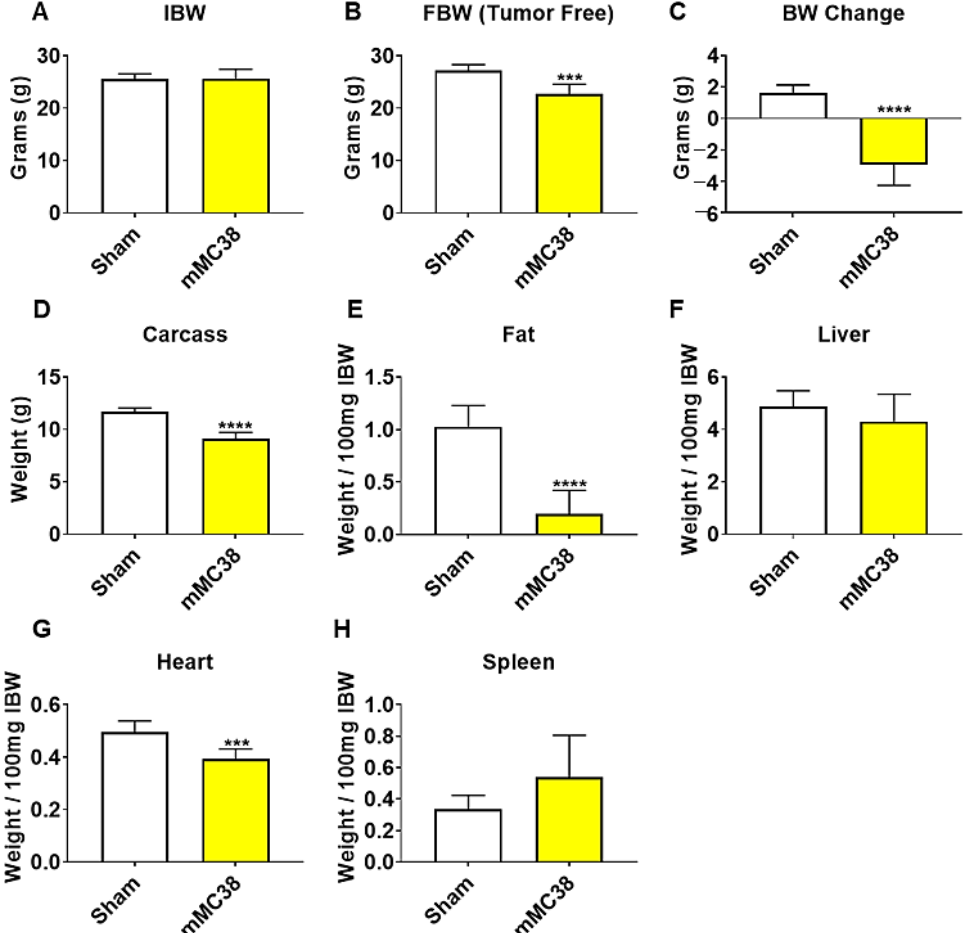
Figure 4. Formation of MC38 liver metastases promotes severe cachexia. ( A – D ) Initial body weight (IBW) ( A ), tumor-free final body weight (FBW) ( B ), BW change ( C ) and carcass weights ( D ) of C57BL/6 male mice (8 weeks) intrasplenically injected with MC38 tumor cells (1.25 × 10 5 cells/mouse in sterile PBS: mMC38) or an equal volume of vehicle (sham) ( n = 5 – 8). ( E – H ) Fat ( E ), liver ( F ), heart ( G ) and spleen ( H ) weights normalized to IBW. Data presented as mean ± s.d. *** p < 0.001, **** p < 0.0001 vs. sham.